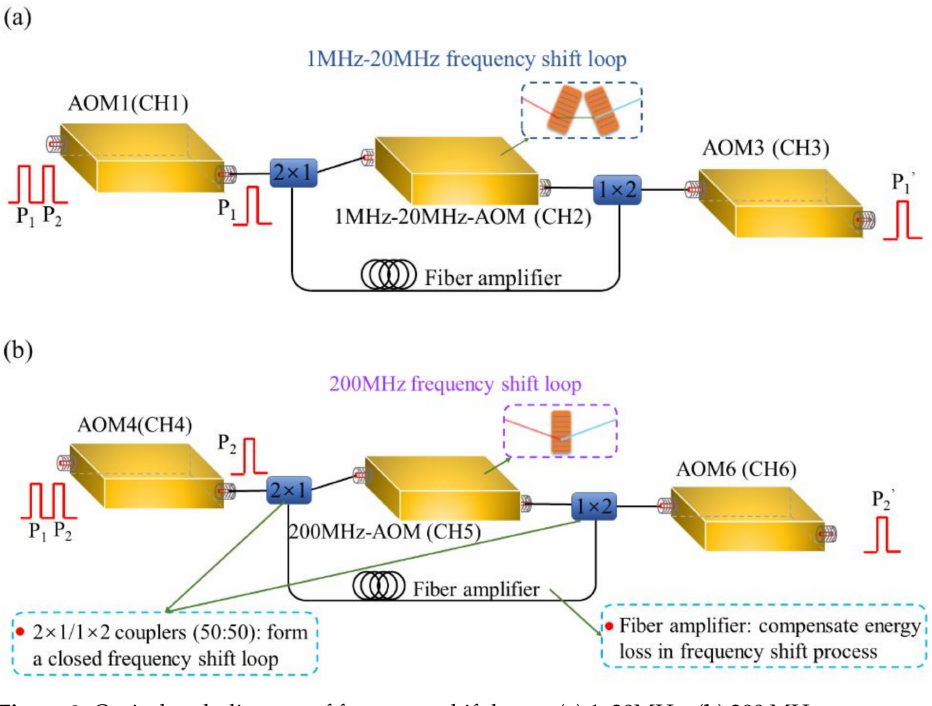
Figure 3. Optical path diagram of frequency shift loops: ( a ) 1–20MHz; ( b ) 200 MHz.